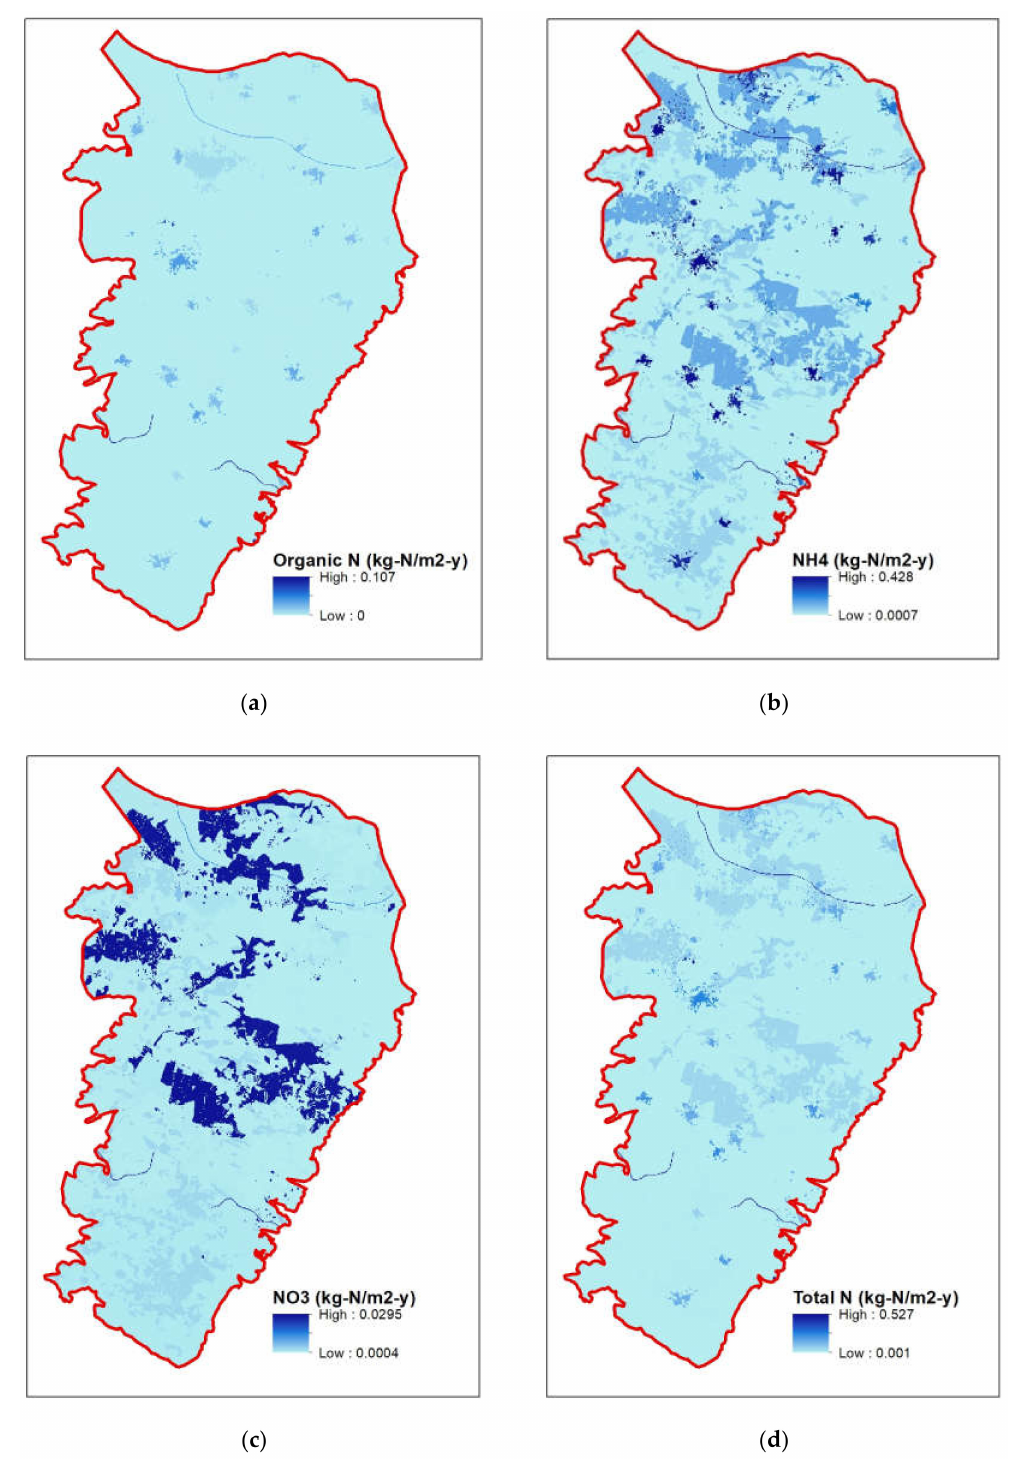
Figure 7. The spatial distribution of the annual on-ground amounts (kg-N / m 2 · year) of the di ff erent nitrogen species and the total annual nitrogen in the area of the Eocene aquifer. Note that each map has its own minimum and maximum values for the stretched coloring ramp. ( a ) for organic nitrogen, ( b ) for ammonium, ( c ) for nitrate and ( d ) for total